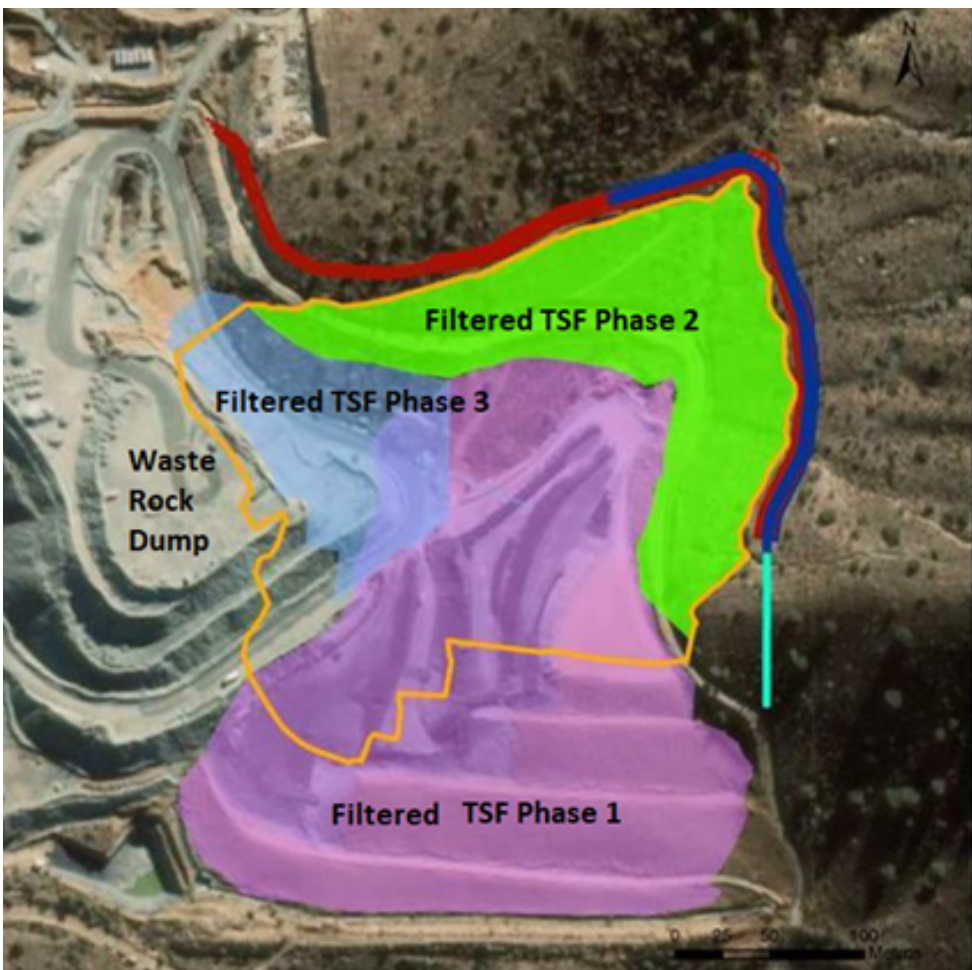
Figure 42. Tambo de Oro Filtered Tailings Storage Facility—Layout [49].